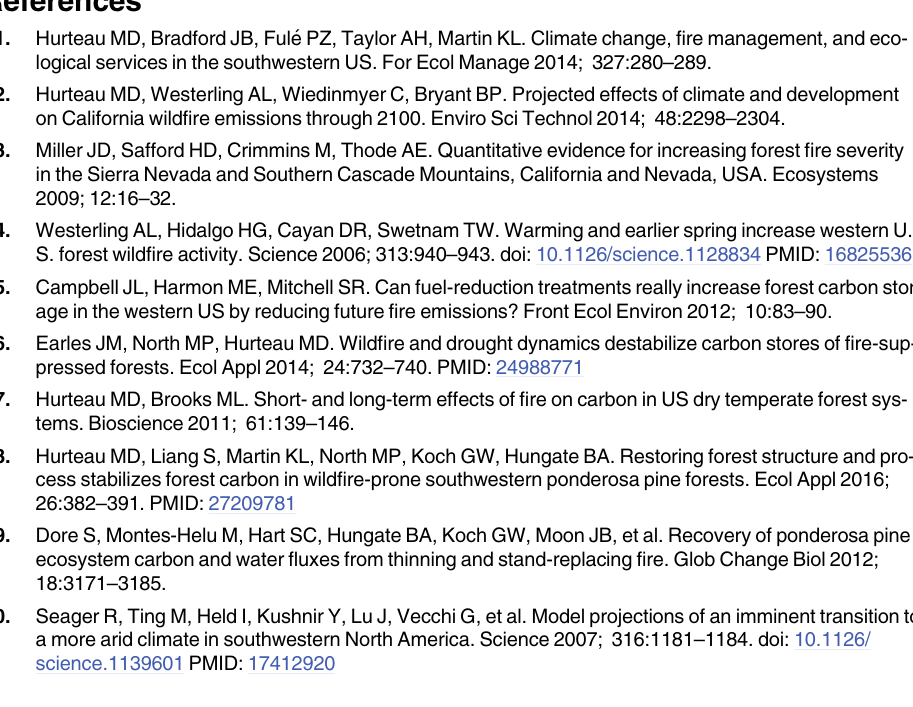
S4 Table. Comparison of year 100 total ecosystem carbon with wildfire. Comparison of